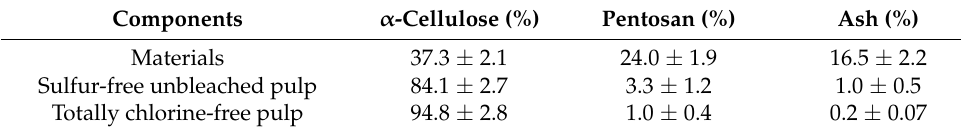
Table 3. Chemical composition of pure cellulose from Nypa fruticans fronds. Components